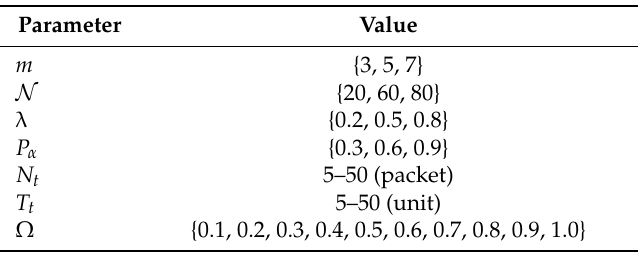
Table 2. Simulation parameters.